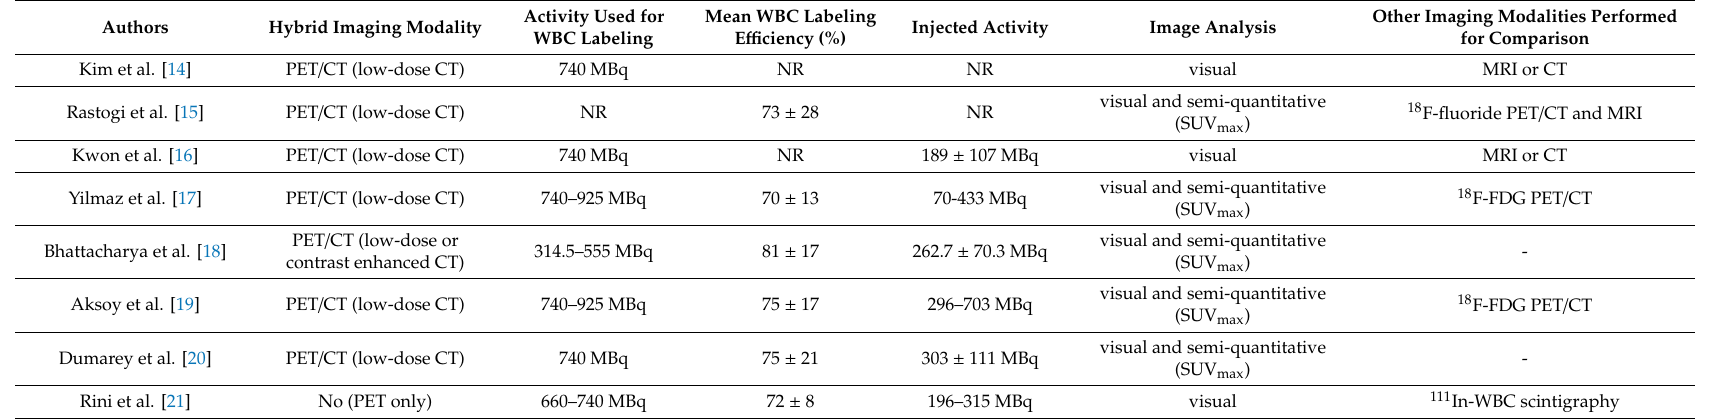
Table 2. Technical aspects of the included studies.